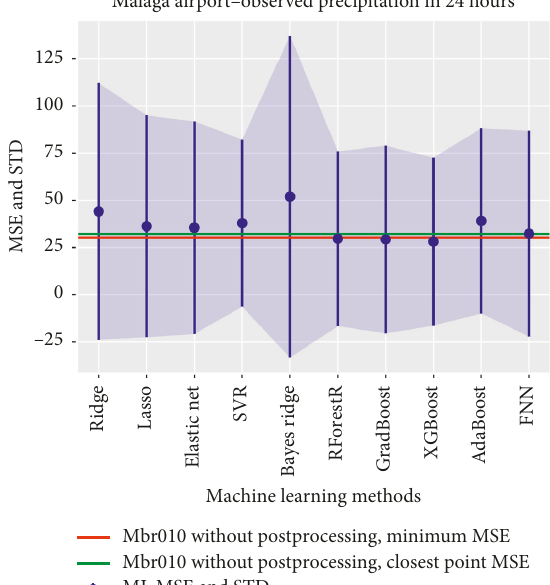
Figure 22: Precipitation in 24hours, calibration plot for M´alaga airport. Horizontal axis as in Figure 18.